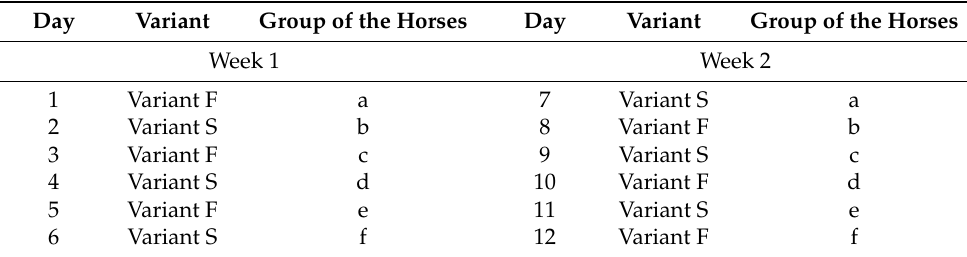
Table 1. The order of the test